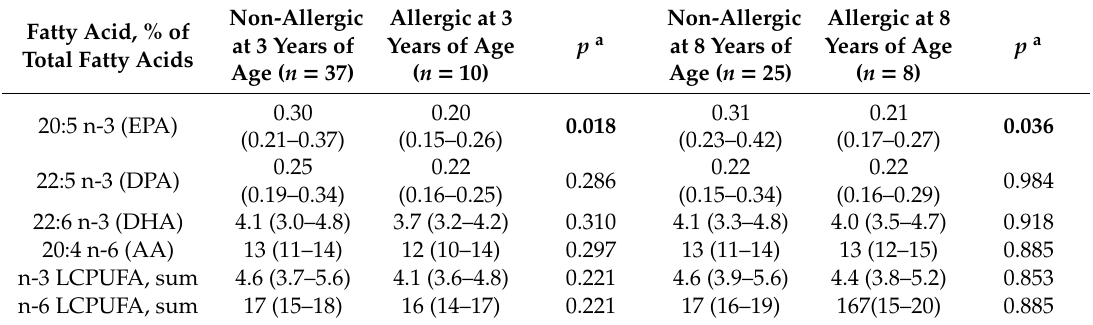
Table 6. Proportions of long-chain polyunsaturated fatty acids in cord serum in relation to allergy diagnosis at 3 and 8 years of